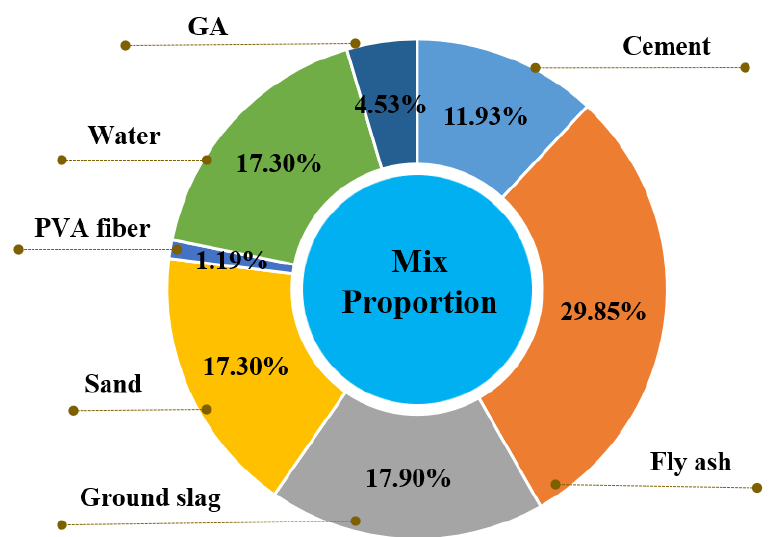
Figure 1. Mix proportion of ECC.